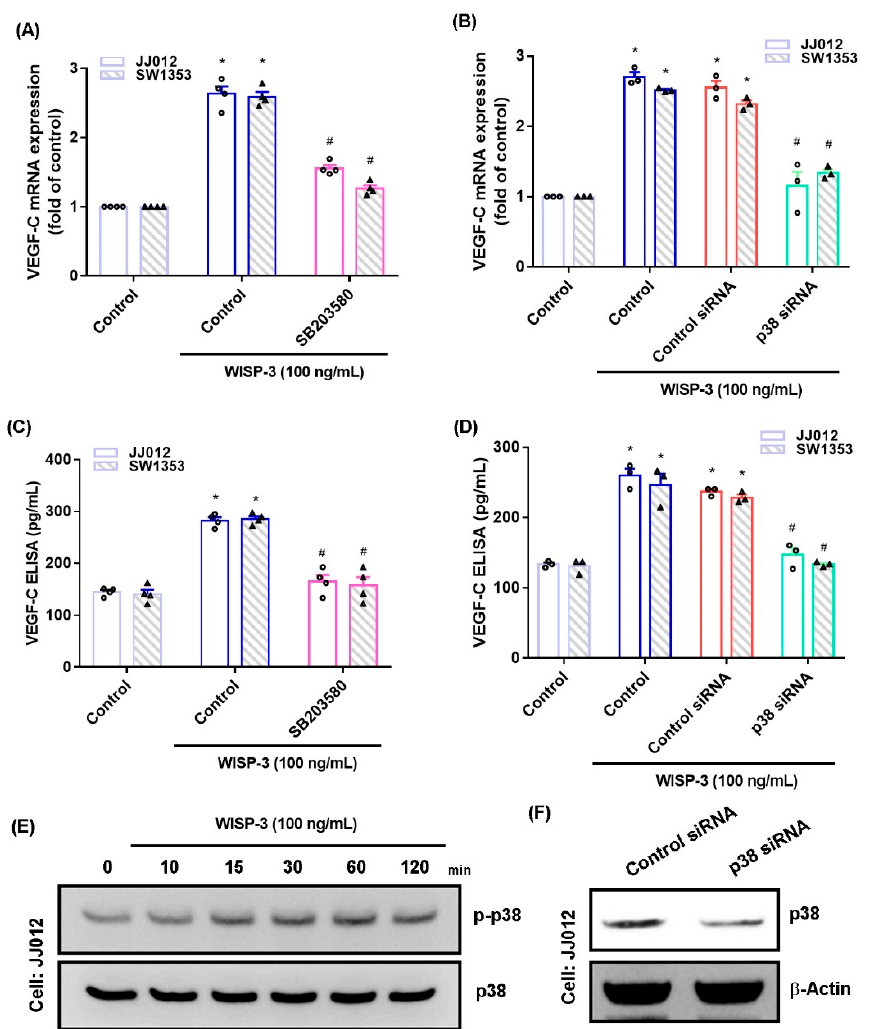
Figure 4. The p38 pathway controls WISP-3-induced VEGF-C production . ( A – D ) Cells were pre- treated with a p38 inhibitor (SB203580) or transfected with a p38 siRNA, then stimulated with WISP-3. Levels of VEGF-C expression were examined by qPCR and ELISA. ( E ) JJ012 cells were incubated with WISP-3 for the indicated time intervals, and p38 phosphorylation was examined by Western blot. ( F ) JJ012 cells were transfected with p38 siRNA, and p38 expression was examined by Western blot. Quantitative results are expressed as the mean ± SD. All experiments were repeated 3 to 5 times (solid squares, solid dots, hollow circles and solid triangles). * p < 0.05 compared with the control group; # p < 0.05 compared with the WISP-3-treated